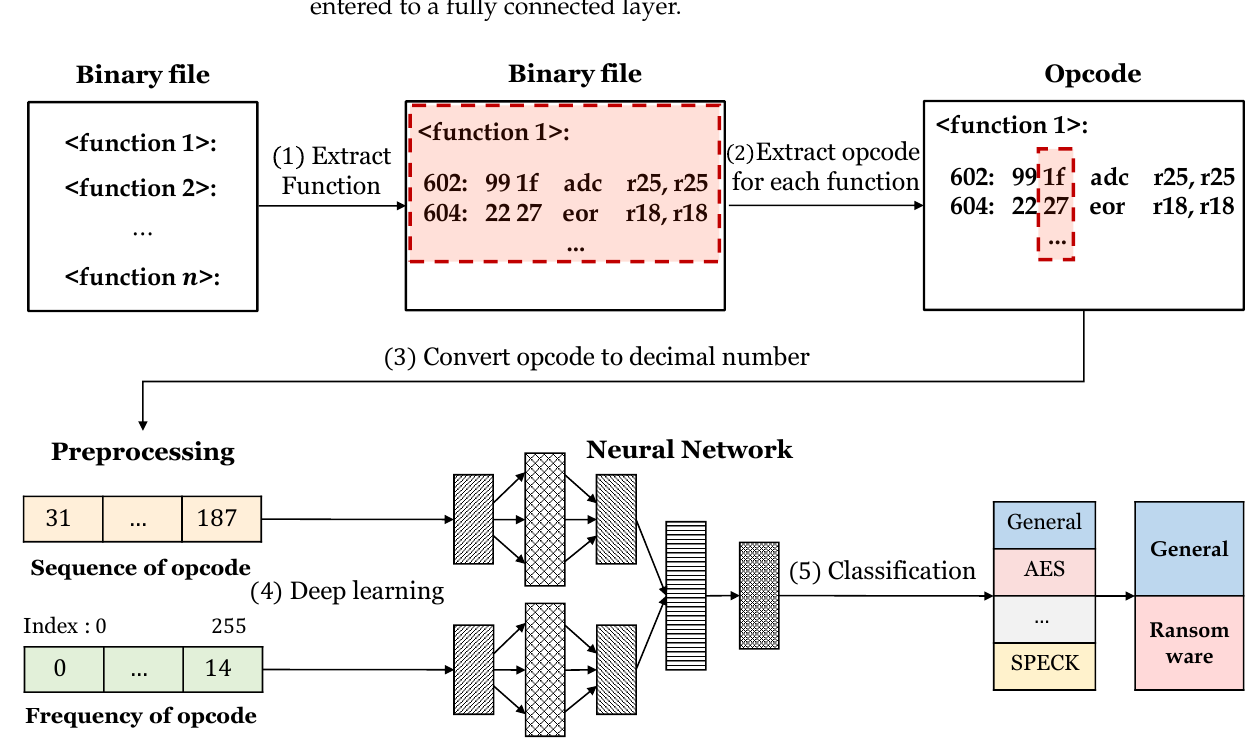
Figure 1. System configuration for proposed